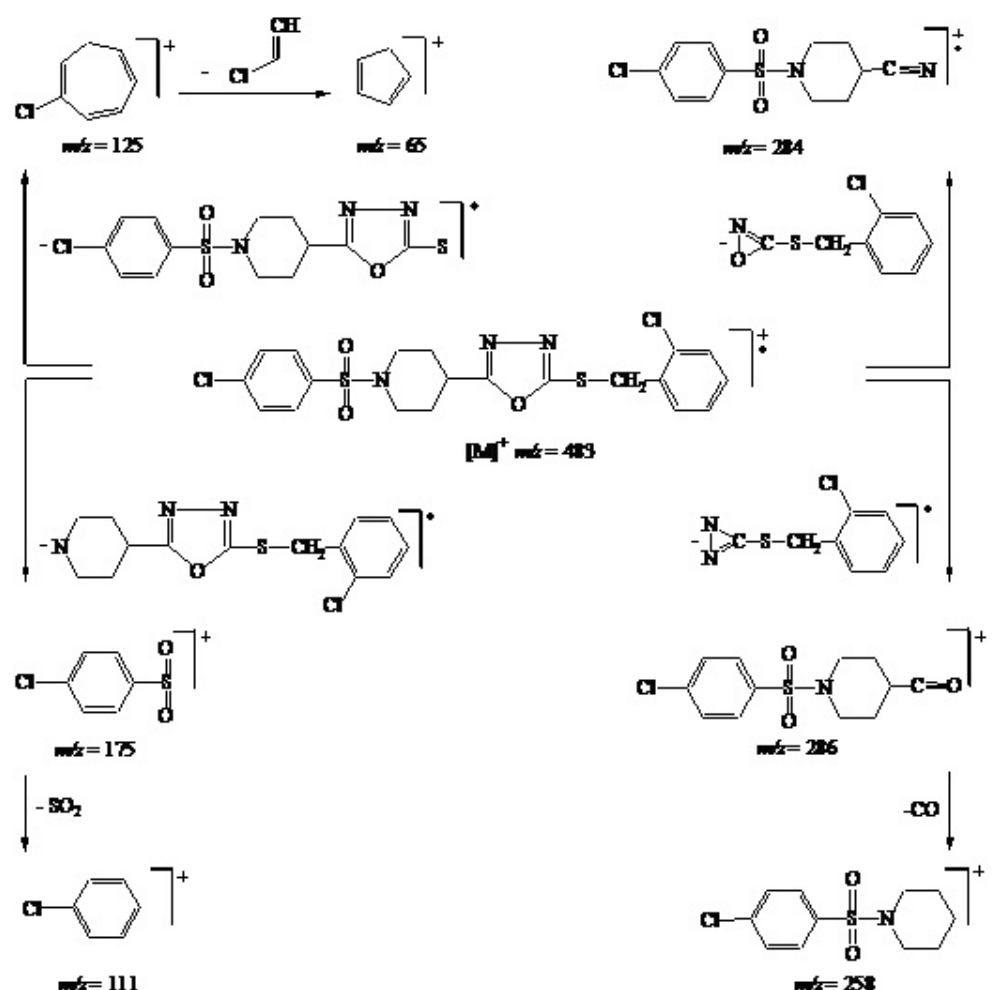
FIGURE 2 - Proposed mass fragmentation pattern of 5-{1-[(4-chlorophenyl)sulfonyl]piperidin-4-yl}-2-[(2-chlorobenzyl)thio]- 1,3,4-oxadiazole ( 7n